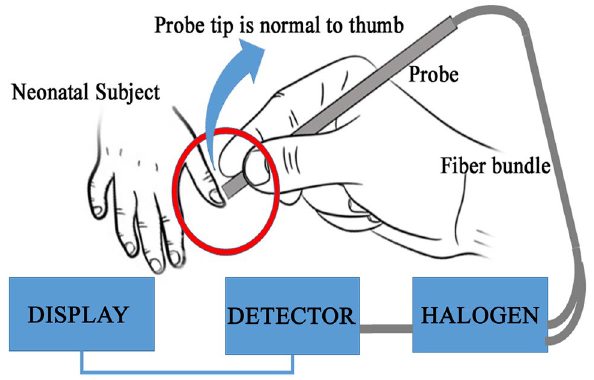
Figure 1. The technique used by the new non-invasive device, AJO-Neo to collect information about bilirubin from the neonatal nail bed. A probe consisting of six illumination fibers and one collection fiber is placed perpendicular to the thumbnail plate as described in our previous study (Ref. 18 ). The illumination fiber is connected to the light source i.e., halogen and collection fiber is connected to the detector. Illumination fiber illuminates the sublingual arcade below the nail plate with a particular light dose, collection fiber collects the reflected light (which carries the information from the blood) and carries it to the spectroscopic detector. Indigenously designed program analyses the data, compute the bilirubin level, and displays the value in the